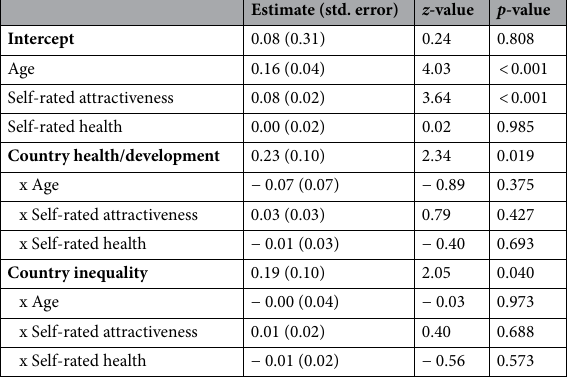
Table 1. The estimated fixed effects for the model of women’s preference for masculinity in male